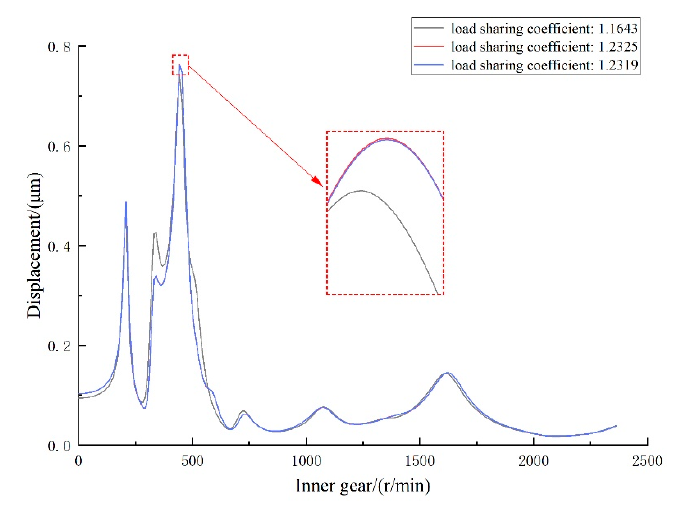
Figure 10. Vector displacement curve diagram of inner gear.